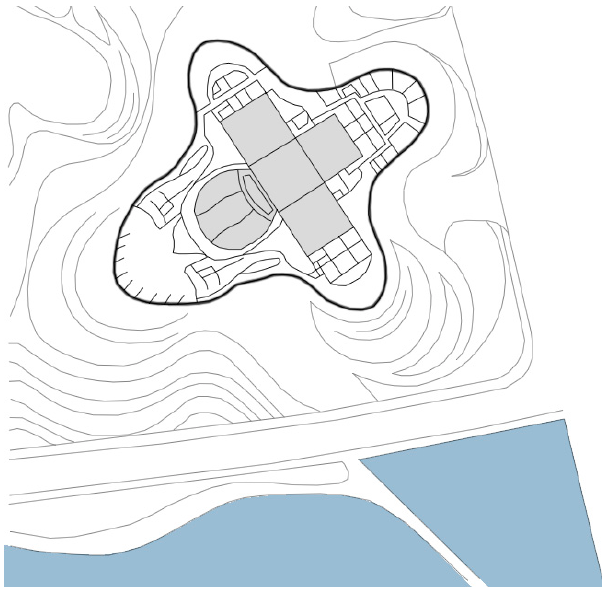
Figure 18. Projection of Changsha Meixihu International Contemporary Art Museum, graphic processing, based on Google Maps and [32], by E. Latusek.